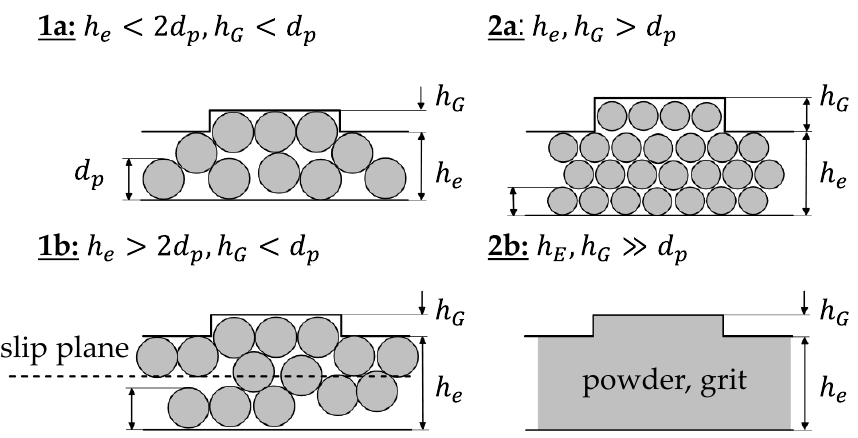
Figure 3. Illustration of the different conveying cases according to [18].